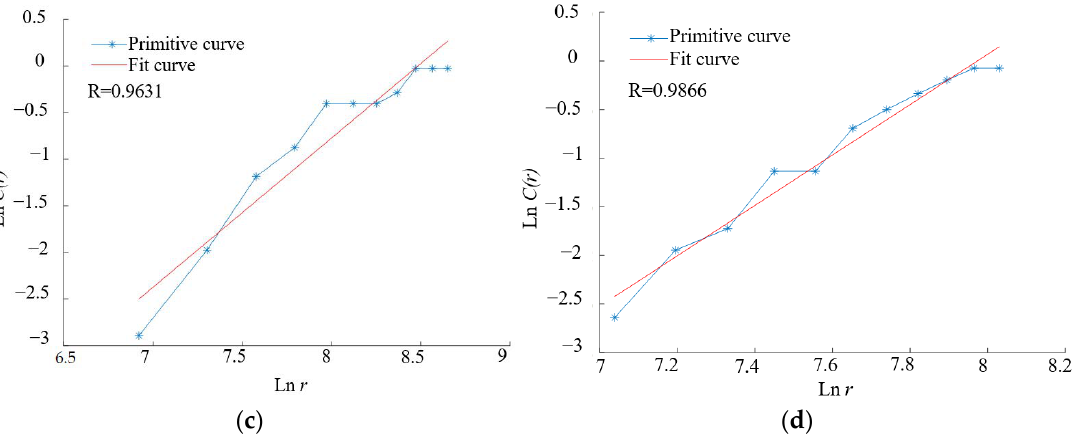
Figure 9. Double logarithmic relationship of AE ring count of the limestone. ( a ) The limestone without a rockburst tendency; ( b ) the limestone with a weak rockburst tendency; ( c ) the limestone with a medium rockburst tendency; and ( d ) the limestone with a strong rockburst tendency.